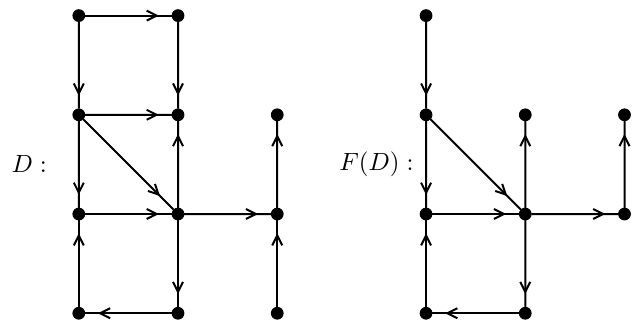
Figure 19: The foundation of a unicyclic